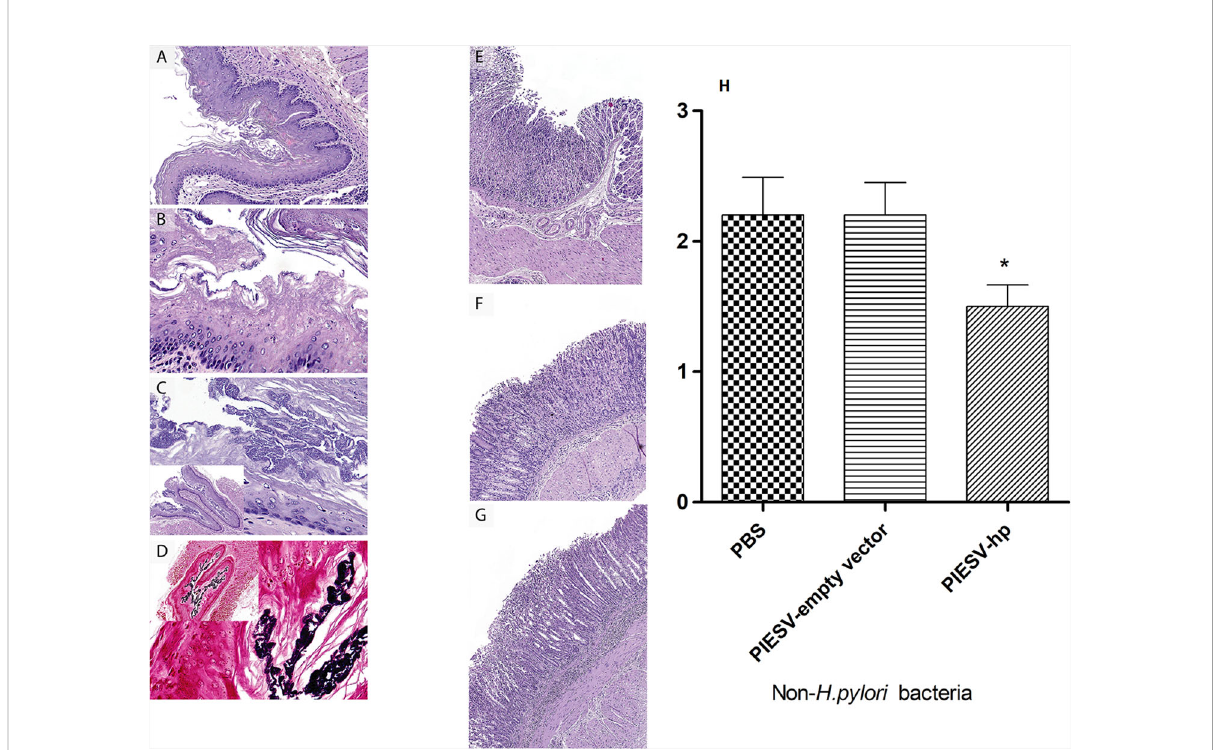
FIGURE 5 Immunization with the PIESV-Hp mixture reduces in fl ammation and the number of Gram-positive rod-shaped bacteria in the mouse stomach. Mice immunized with the PIESV-Hp mixture, the PIESV-empty vector and PBS were infected with ( H ) pylori SS1 two weeks post last immunization. After thirty days, mice were sacri fi ced, and stomach tissues were obtained for H&E staining. (A) Squamous portion of stomach of mice immunized with the PIESV-Hp mixture showed moderate amounts of hyperkeratosis. (B) Abundant hyperkeratosis with moderate numbers of large rod-shaped bacteria (Gram stain) associated with the keratin layer in mice immunized with PIESV-empty vector. (C) Same as B but with much larger populations of gram-positive bacteria in the keratin layer of mice immunized with PIESV empty vector. (D) Same as C but in mice immunized with PBS. Glandular portion of the stomach with (E) mild, (F) moderate, and (G) severe mucosal and submucosal in fl ammation in mice immunized with the PIESV-Hp mixture (E & F) or the PIESV empty vector or PBS (G) . (H) Reduction in the load of rod-shaped bacteria in immunized mice based of relative frequency scores of 0 (absent), 1 (low), 2 (moderate) and 3 (high). P